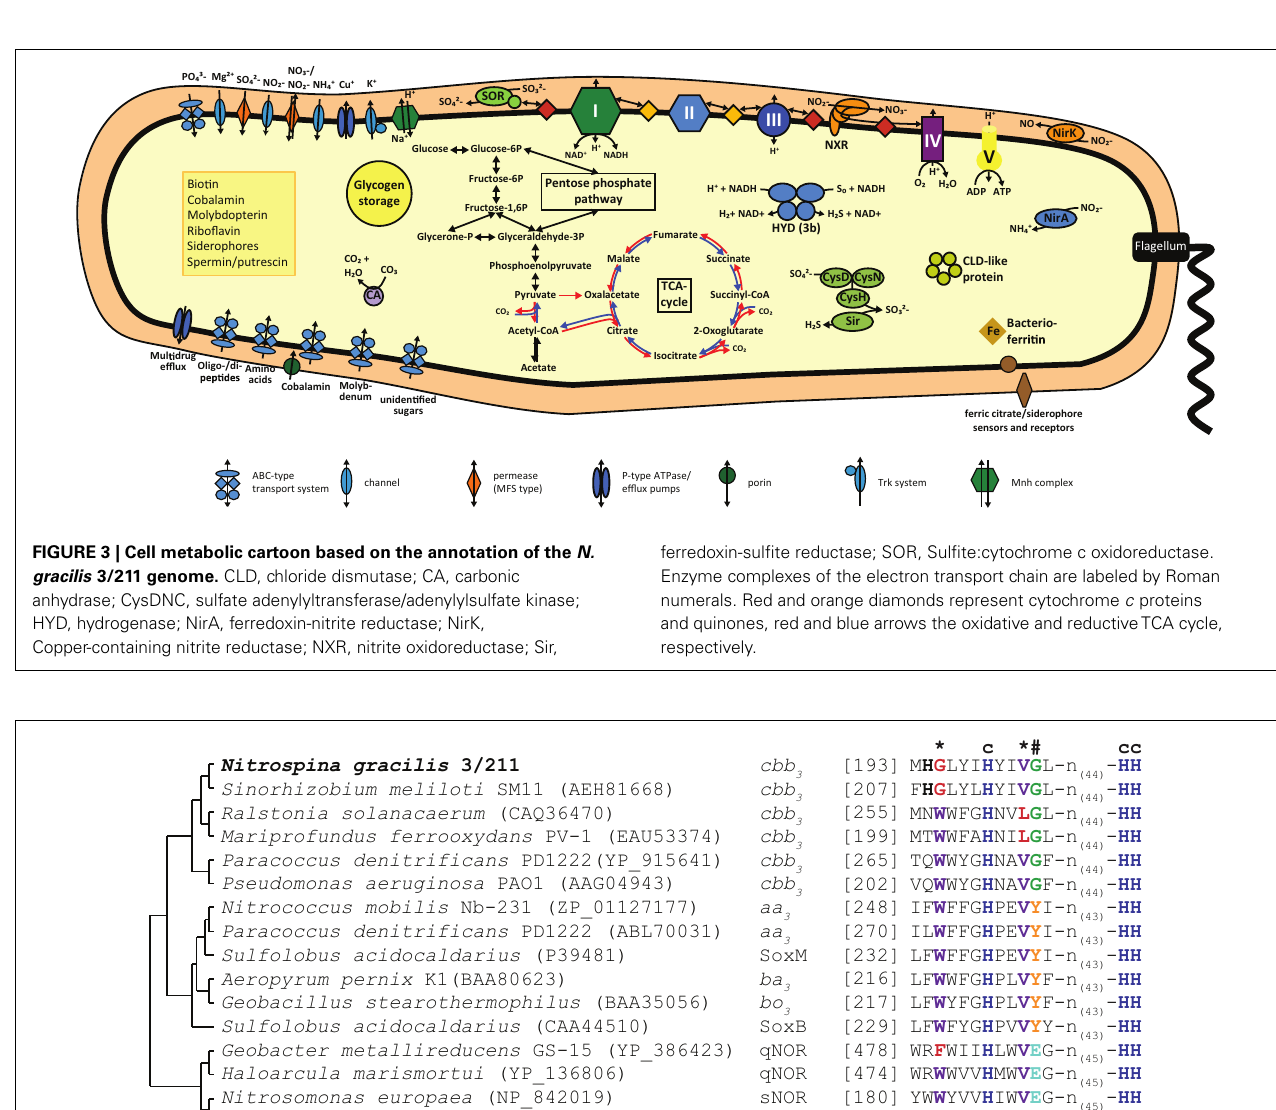
residues involved in Cu B -binding (c); purple, residues involved in electron transport from the high-spin heme to Cu B (*), red, uncommon amino acids; orange, crosslinking tyrosine residue stabilizing one of the Cu B -binding histidines (#), green and turquoise, alternative conserved residues in this position.